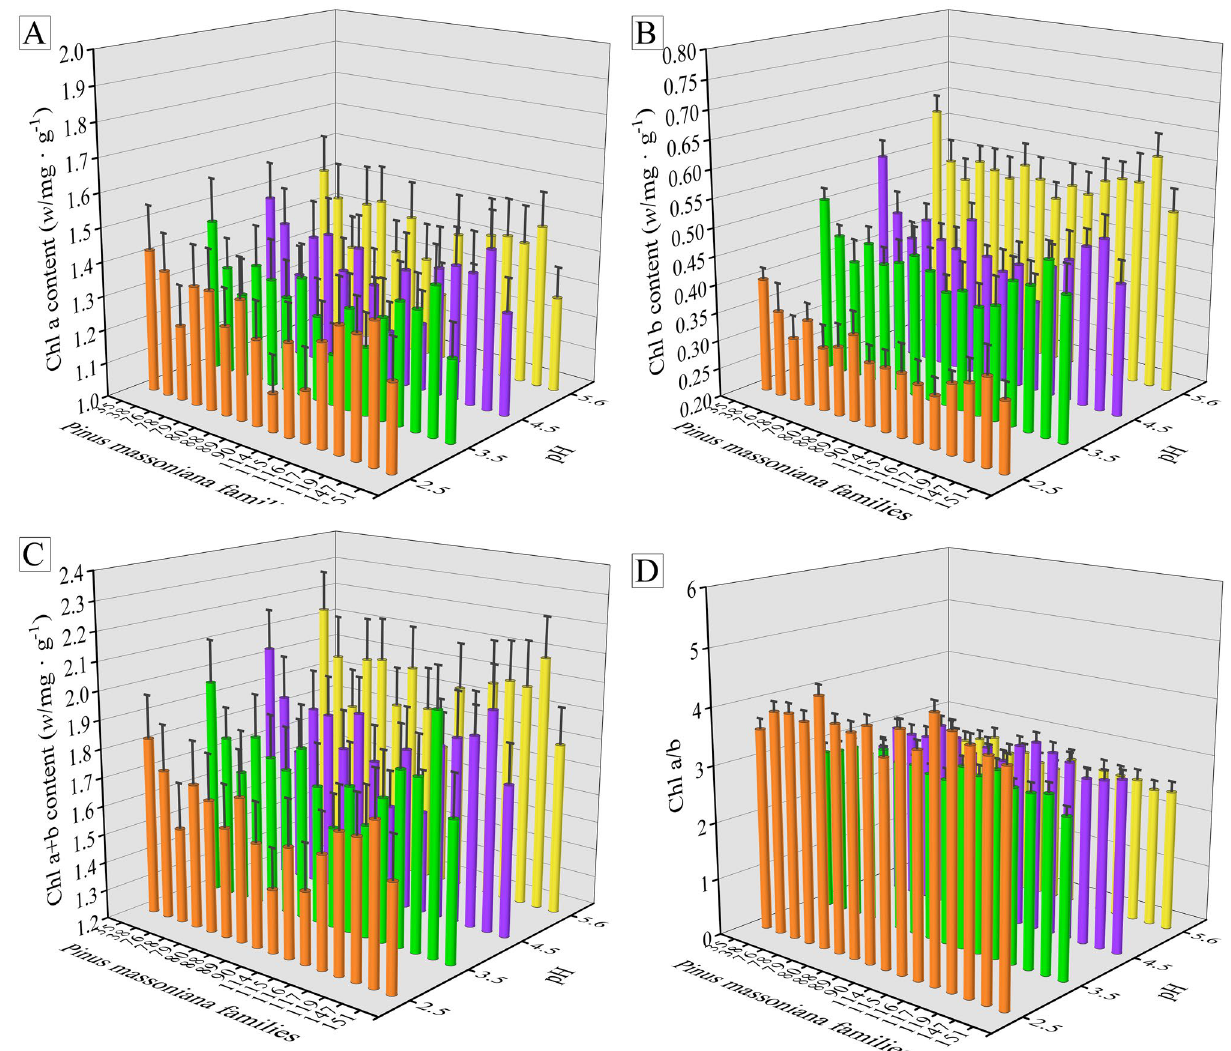
Figure 2. Contents of ( A ) chlorophyll a ( w /mg g −1 ), ( B ) chlorophyll b ( w /mg g −1 ), ( C ) chlorophyll a + b ( w